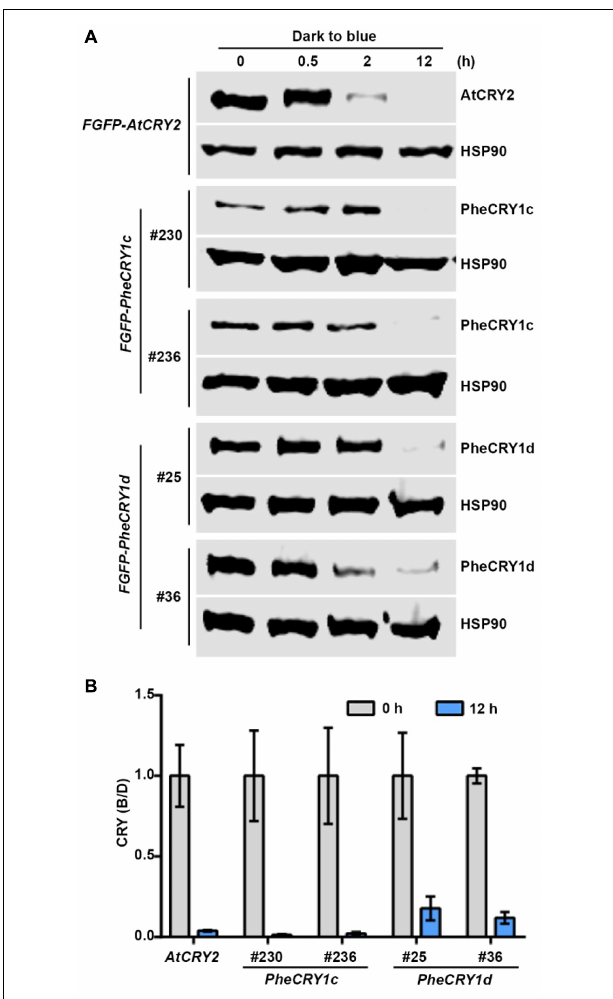
FIGURE 6 | Bamboo PheCRY1s undergo blue light-dependent proteolysis. (A) Immunoblots showing the degradation of PheCRY1 in transgenic Arabidopsis . 6-day-old etiolated seedlings were irradiated with 100 µ molm − 2 s − 1 of blue light for the indicated time. Two independent transgenic lines were used for analysis. Anti-Flag antibody was used to detect AtCRY2 and PheCRY1. Anti-HSP90 antibody was used to detect HSP90. HSP90 is used as a loading control. (B) Quantitative analysis of CRY protein degradation at time 0 and 12 h of blue light treatment from immunoblots shown in (A) . CRY (B/D) = [CRY/HSP90] blue /[CRY/HSP90] dark . Data are presented as mean ± SD ( n = 3 individual